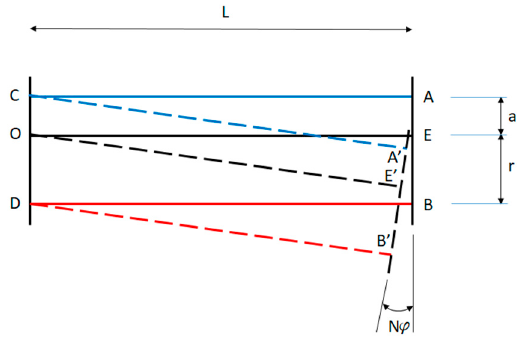
Figure 5. Sketch of the 2D model.